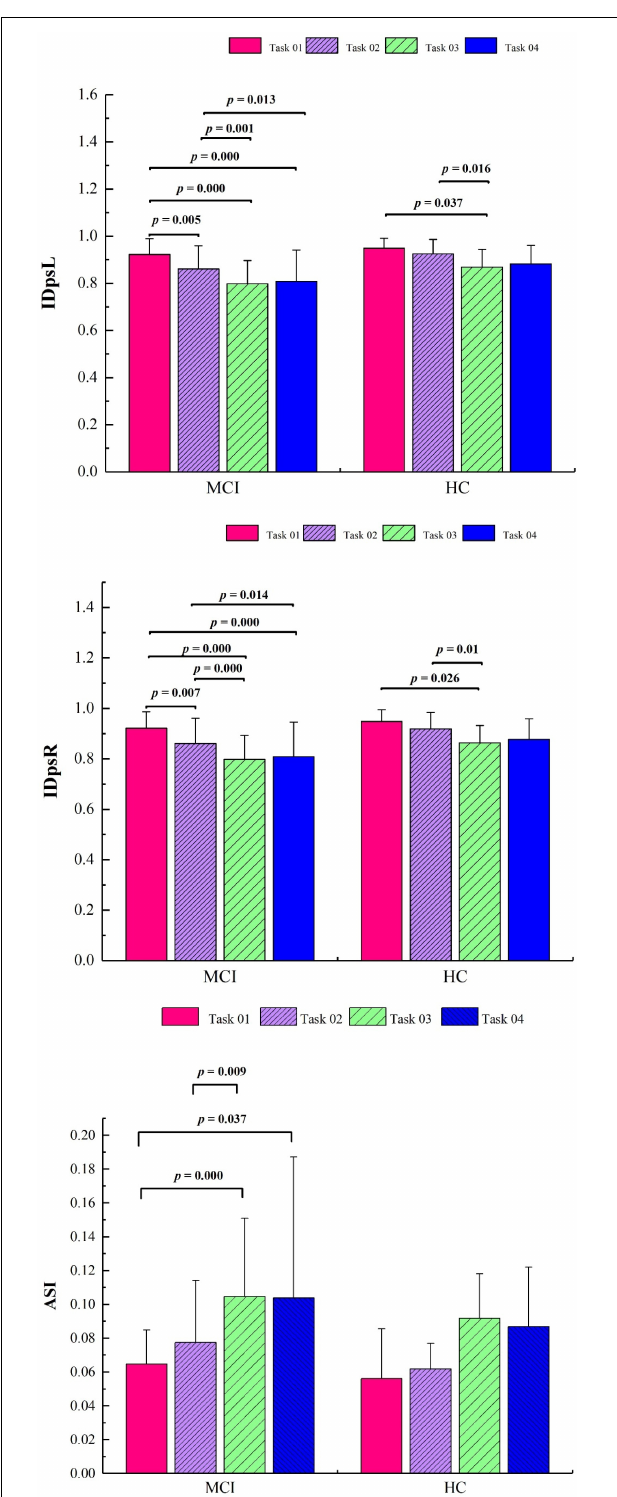
FIGURE 6 | Significant results of gait symmetry indices for four tasks in the two groups. IDpsL, left relative symmetry index; IDpsR, right relative symmetry index; ASI, asymmetry index; HC, healthy control; MCI, mild cognitive impairment.